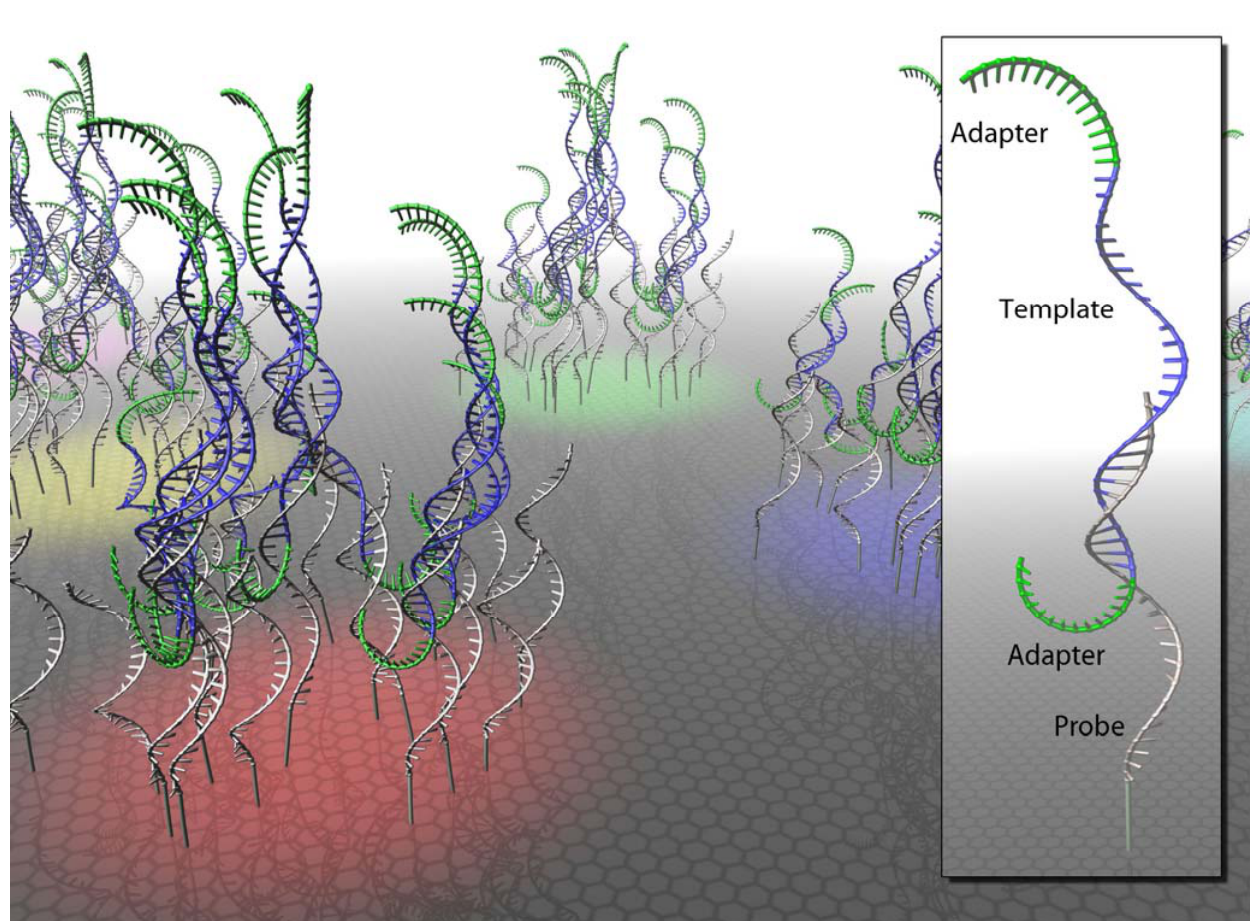
Figure 1. Hybridization capture on a microarray. Single-stranded oligonucleotide probes are arranged in clusters (red, yellow, green and blue surface colors) on a glass slide. Captured sequencing libraries consist of single-stranded target molecules (blue) and flanking sequencing adapters